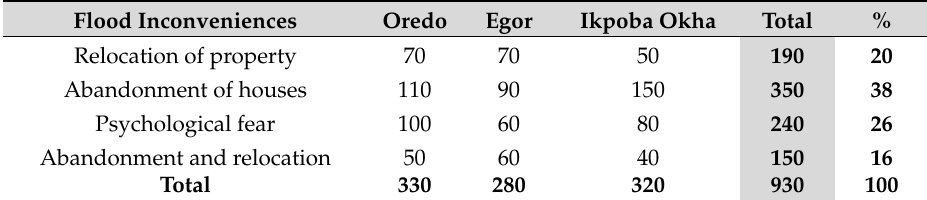
Table 4. Inconveniences caused by flooding to Benin City residents.